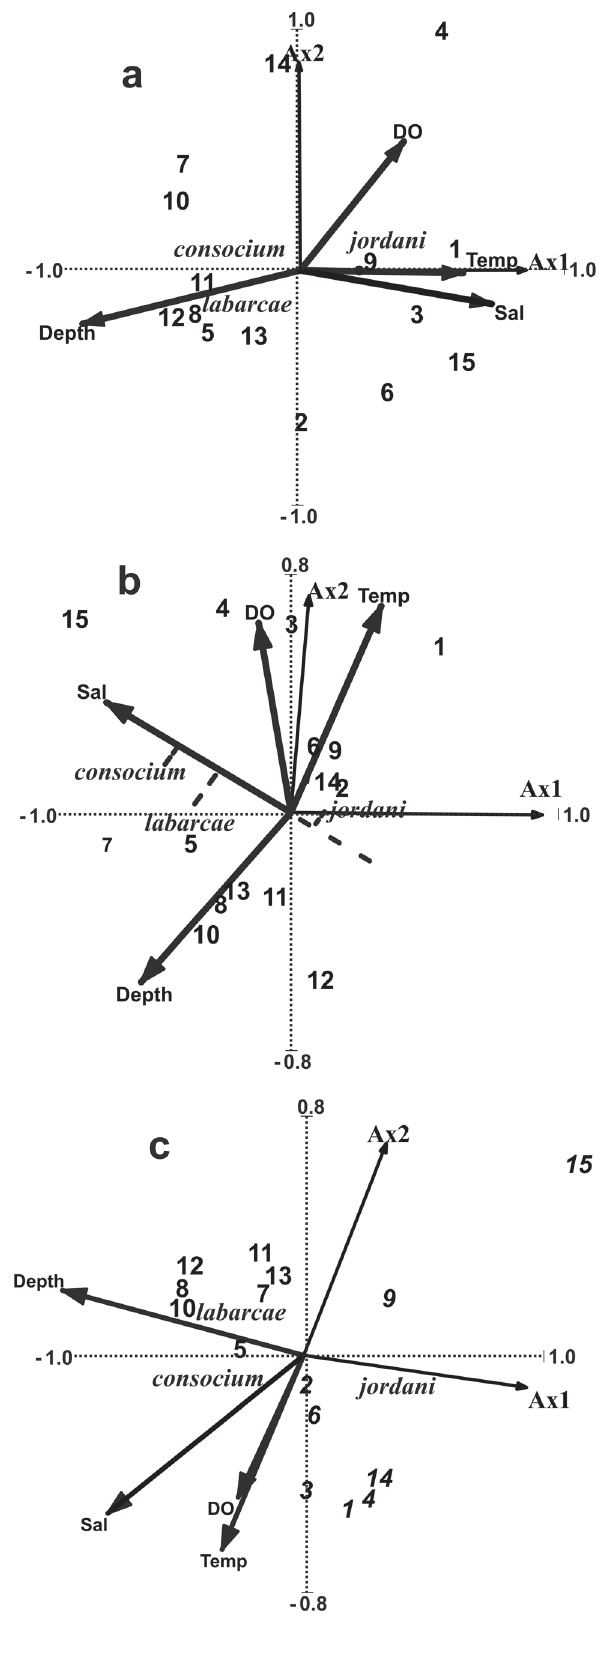
Fig. 5. (left column) Distribution-based Redundancy Analysis (db-RDA) ordination diagram of Lake Chapala with environmental variables (thick arrows), atherinopsids species (italic letters), sampling sites (numbers), and principal coordinates axes (thin arrows) at dry season ( a: May of 1999) and rainy season ( b: August of 1999; c: 2000). The fish are: jordani = Chirostoma jordani ; consocium = Chirostoma consocium ; labarcae = Chirostoma labarcae . The environmental variables are: Temp = temperature, DO = dissolved oxygen, Sal = salinity. In figure 5c shallow sites are in italic and deep sites in